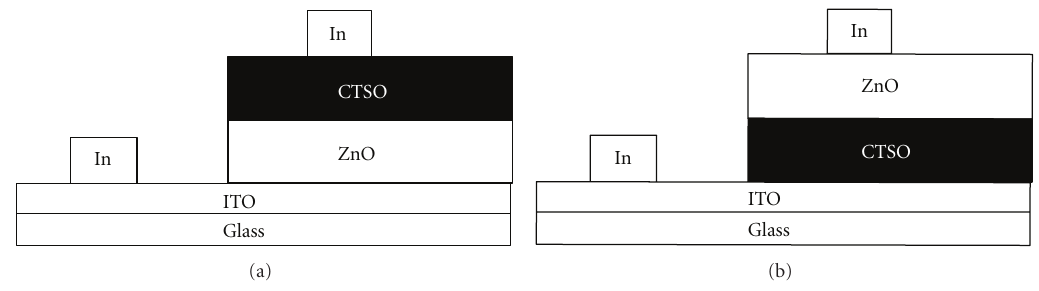
Figure 1: Schematic illustrations of (a) the CTSO/ZnO superstrate heterostructure and (b) the ZnO/CTSO substrate heterostructure. For the substrate structure (b), the light should be incident on the ZnO side through a transparent electrode. However, since the metal electrode was deposited on ZnO, the light was incident on the substrate side in the